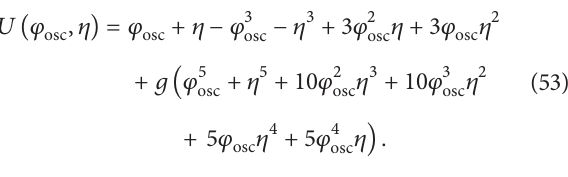
Figure 5: Density plot of a Breather. Solution with Lorentz symmetry breaking (left) and to the one Lorentz symmetry (right).